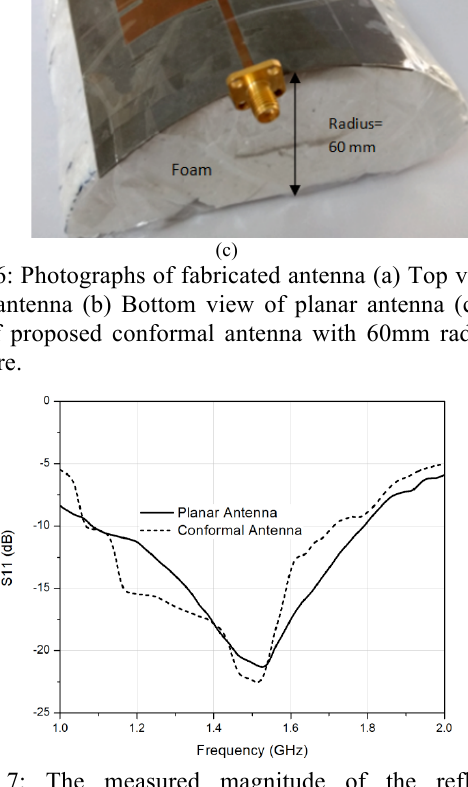
Figure 7: The measured magnitude of the reflection coefficient of planar and conformal antenna.